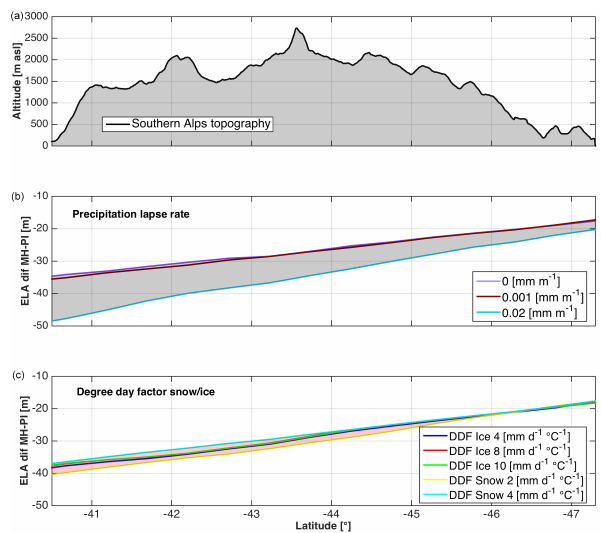
Figure 7. Sensitivity of ELA differences in the Southern Alps to precipitation lapse rate and DDF of snow and ice. (a) Latitudinal topography profile of Patagonia (SRTM 1km), ( b ) ELA difference sensitivity to precipitation lapse rate, and (c) ELA difference sen- sitivity to DDF of snow and ice. Grey and pink areas in (b) and (c) represent the range in ELA differences between MH and